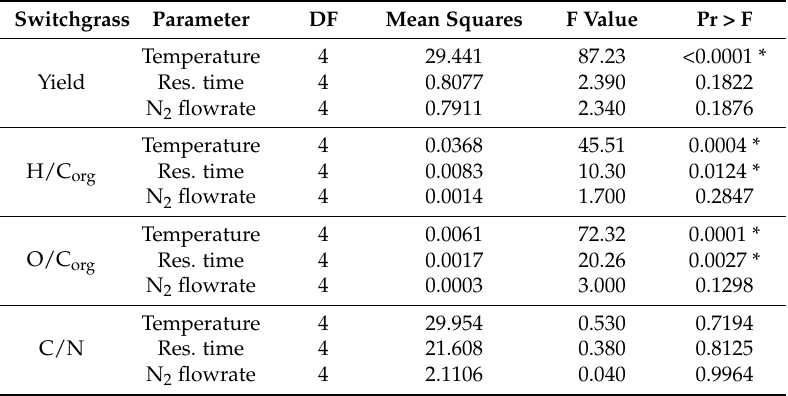
Table A5. ANOVA for the model of switchgrass